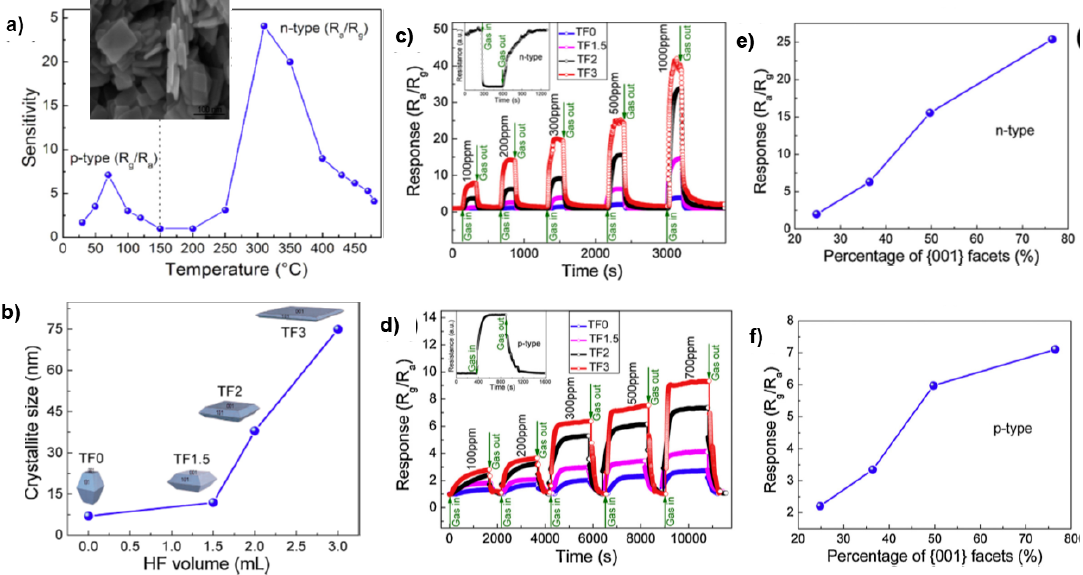
Figure 9. The sensitivity of TiO 2 nanosheet-based sensor to 500 ppm alcohol at various temperatures and a typical SEM image ( a ). The average crystallite size and the corresponding schematic shape of TiO 2 nanocrystals as a function of the HF amount ( b ), the response with recovery curves of the sensors based on the four kinds of TiO 2 samples as a function of ethanol concentration at the operating temperatures of 310 °C ( c ) and 70 °C ( d ). Response values of the sensors based on the four kinds of TiO 2 samples (up to 500 ppm of ethanol) as a function of the percentage of exposed {001} facets at 310 °C ( e ) and at 70 °C ( f ). Reprinted with permission from ref. [9,10].